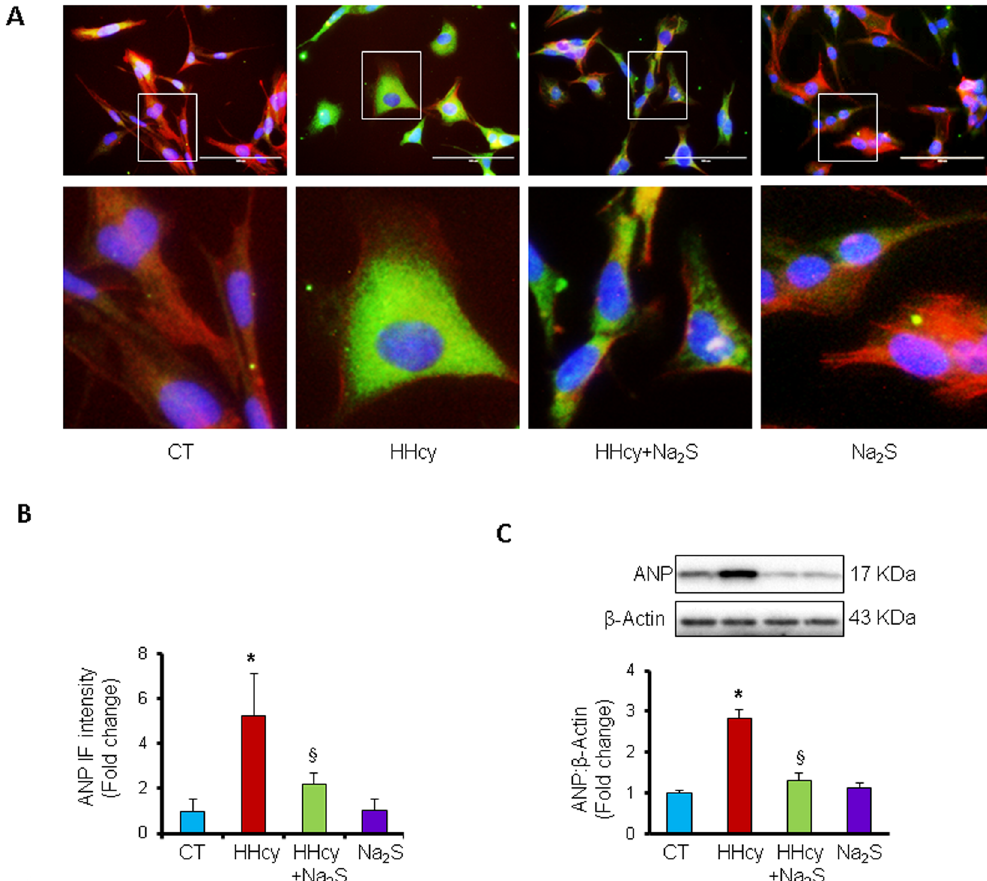
Figure 6. Hydrogen sulfide donor Na 2 S mitigates homocysteine-mediated upregulation of atrial-natriuretic peptide (ANP) in HL1 cardiomyocytes. ( A ) Representative immunocytochemistry of ANP (green) and β -tubulin (red) in cardiomyocytes treated with either nothing (CT), 100 µ M of Hcy (HHcy), HHcy with 30 µ M of Na 2 S (HHcy + Na 2 S), or 30 µ M of Na 2 S (Na 2 S). n = 20 cells per group from three independent experiments. ( B ) Quantification of ANP immunofluorescence intensity in the above four groups of cardiomyocytes. ( C ) Western blot showing the relative expression of ANP. Values are represented as mean ± SEM. N = 5. p < 0.05 is considered statistically significant. “ * ” Represents statistically significant value when compared to the untreated control, and “§” represents statistically significant value when compared to the HHcy + Na 2 S treated cells. Scale bar: 100 μ